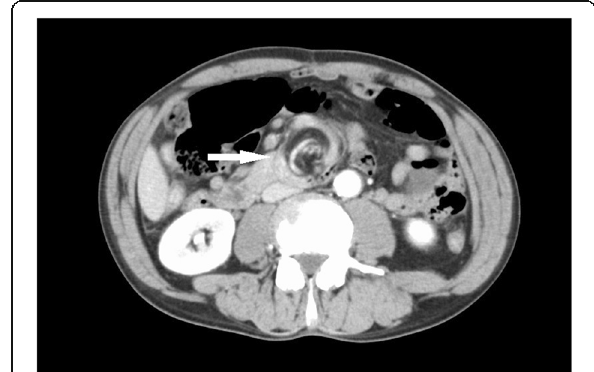
Fig. 1 Enhanced abdominal CT shows the whirl sign (arrow) involving the superior mesenteric artery as the center